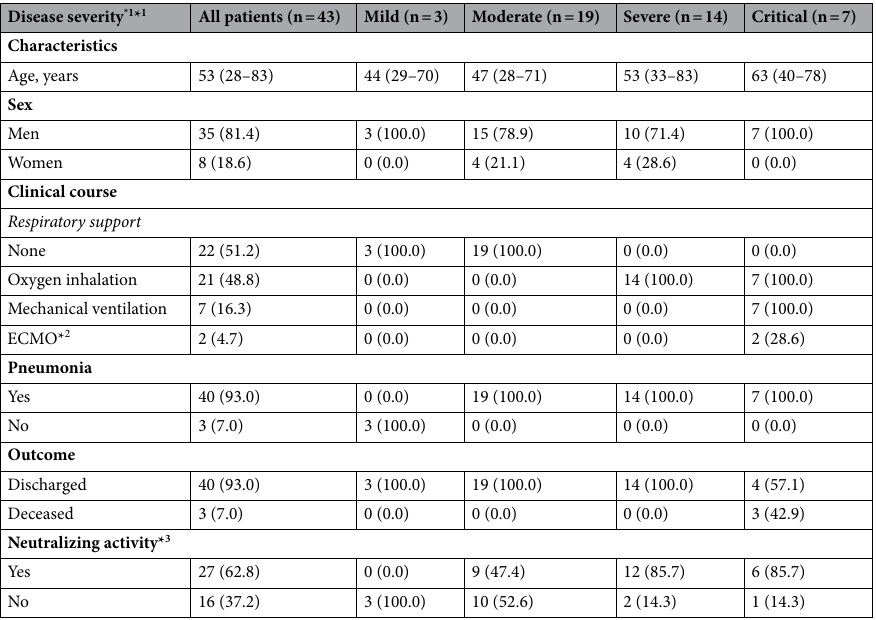
Table 1. Summary of the patient characteristics. * 1 Disease severity definitions. Mild: febrile or fatigue but no pneumonia identified; Moderate: febrile, fatigue, moderate pneumonia identified, but no dyspnea and no oxygen inhalation required; Severe: febrile, fatigue, dyspnea, severe pneumonia identified, and oxygen inhalation required; Critical: febrile, fatigue, severe dyspnea, critical pneumonia identified, and positive pressure ventilation plus extracorporeal membrane oxygenation (ECMO* 2 ) required. * 3 For the detail of neutralizing activity, see Fig.